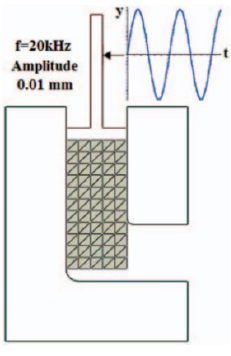
Figure 11. FEM (finite element method) models of ECAP reprinted from ref. [41]. Copyright 2022 ELSEVIER.